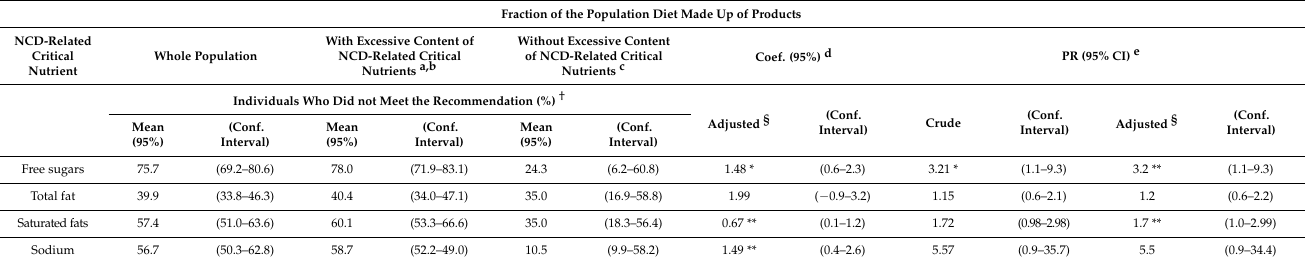
Table 3. Assessment prevalence of non-recommended intake levels of NCD-related critical nutrients † in the whole population, and by fractions of population diet with and without products with excessive content in these critical nutrients ‡